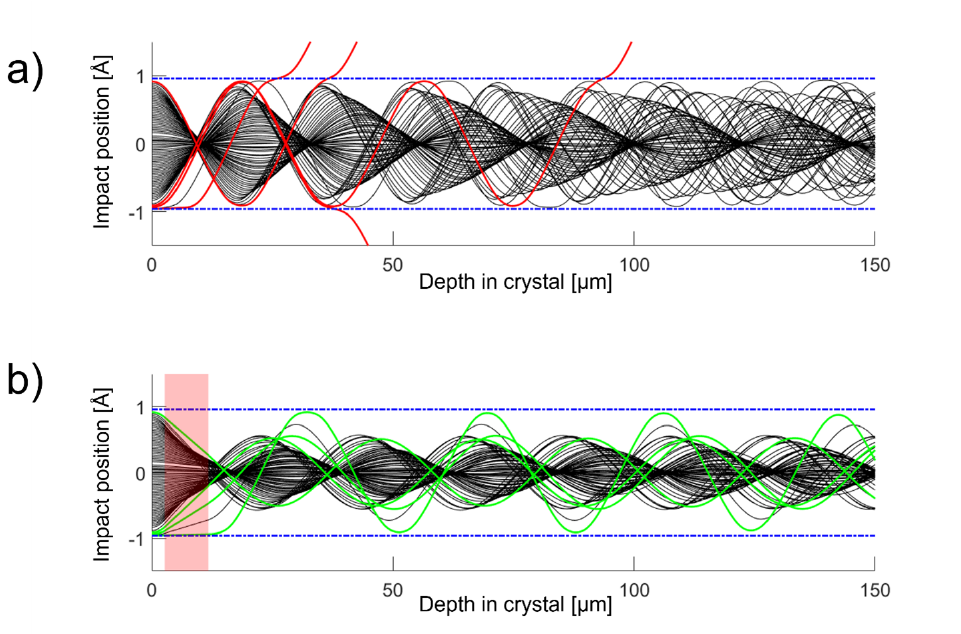
Figure 2. MonteCarlo simulation for 180 GeV/c proton planar channeling. Blue lines indicate atomic planes position ( a ) trajectory for normal crystal, red lines indicate dechanneled particles. ( b ) Crystal is interrupted in the pink area, green lines indicate the trajectory of particle subjected to dechanneling in previous